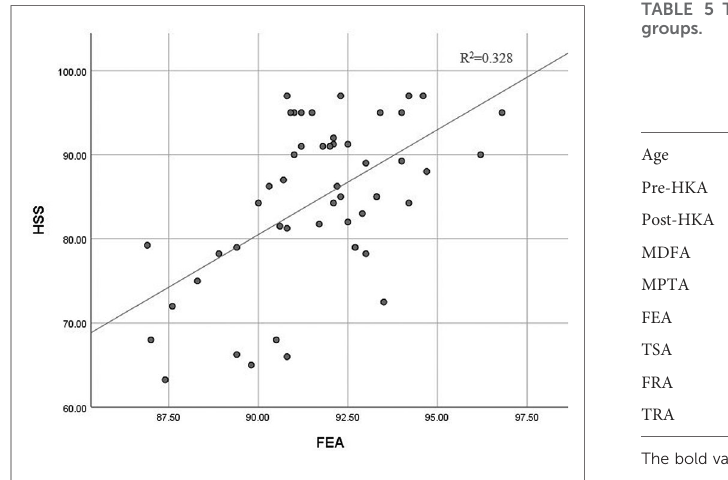
FIGURE 4 Correlation between HSS and FEA (HSS, hospital for special surgery knee scores; FEA, femoral fl exion-extension angle).